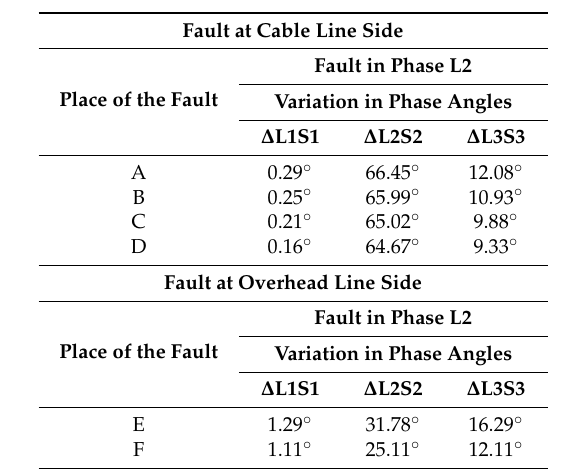
Table 4. Ground fault at overhead and cable line sides in phase L2. Variation in phase angles between currents in the conductors and their respective shields.